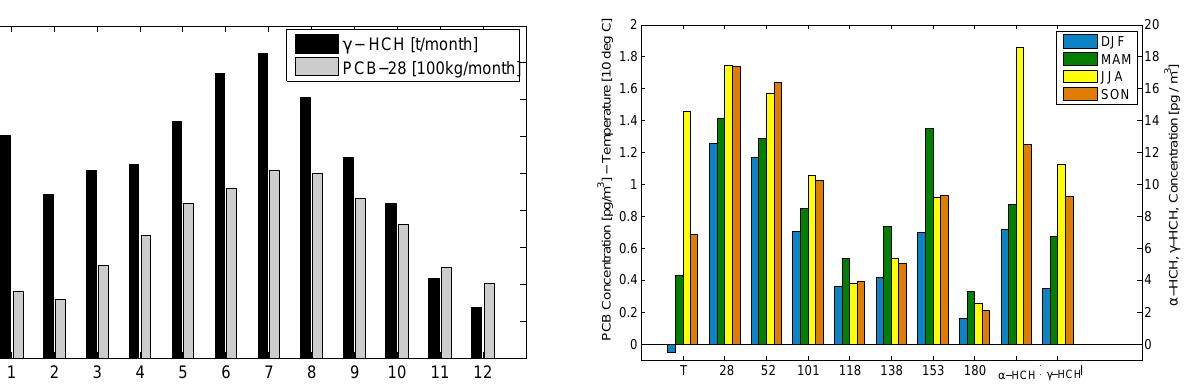
Fig. 3. Temperature ( T ) and concentrations of seven PCB con- geners, α -HCH and γ -HCH [pg/m 3 ] measured at Birkenes in the period 2004–2007 and averaged over the four seasons DJF (Decem- ber to February), MAM (March to May), JJA (June to August) and SON (September to November). Note the different scales for PCBs and